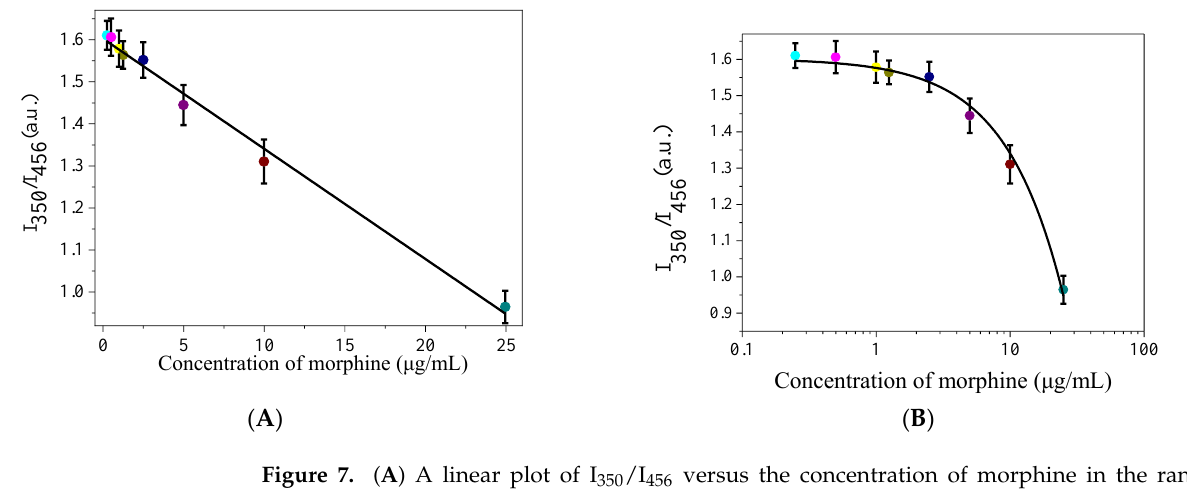
Figure 7. ( A ) A linear plot of I 350 /I 456 versus the concentration of morphine in the range of 0.25–25 μg/mL (n = 3); ( B ) Fitted curves of I 350 /I 456 versus the morphine concentration plotted on a log scale.